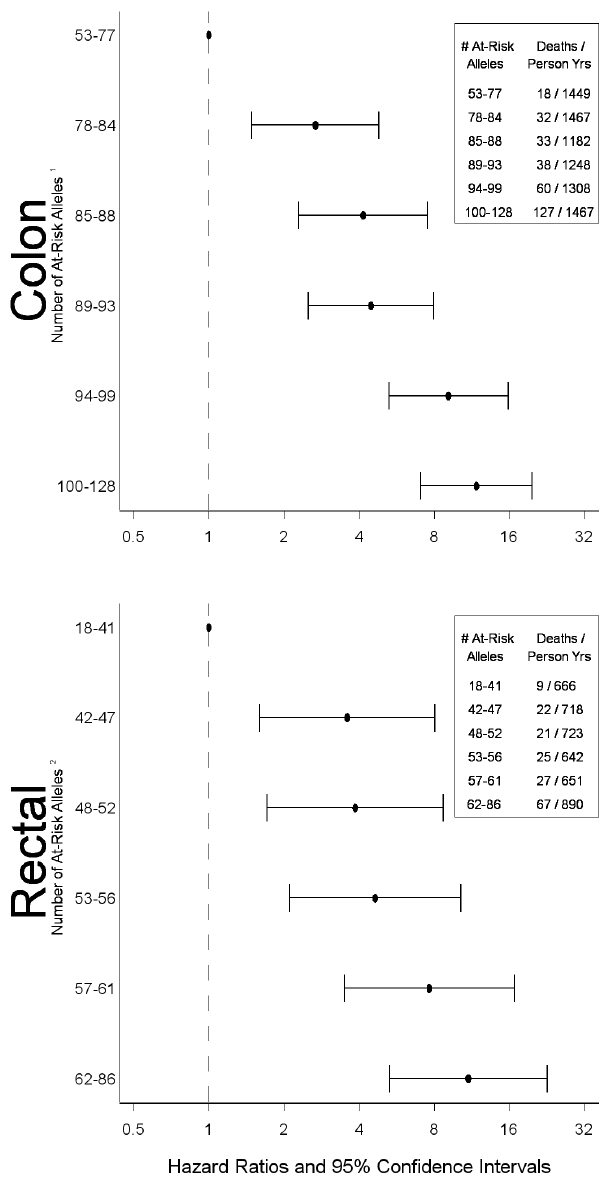
Fig. 1. Polygenic summary score associated with CHIEF pathway for colorectal cancer survival. 1 SNPs included in score: BMP2 rs1979855, rs3178250, BMPR1A rs7895217, rs10887668, BMPR1B